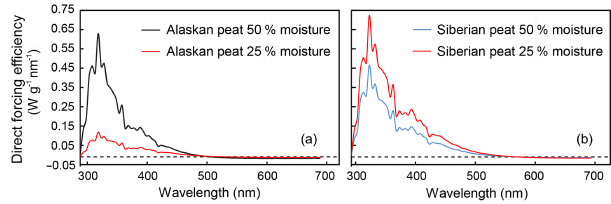
Figure 4. Direct forcing efficiency of brown carbon aerosols above snow (surface albedo = 0.8). Integrated mean forcing is 20 and 38Wg − 1 for Alaskan and Siberian peat smoke aerosols, respec-